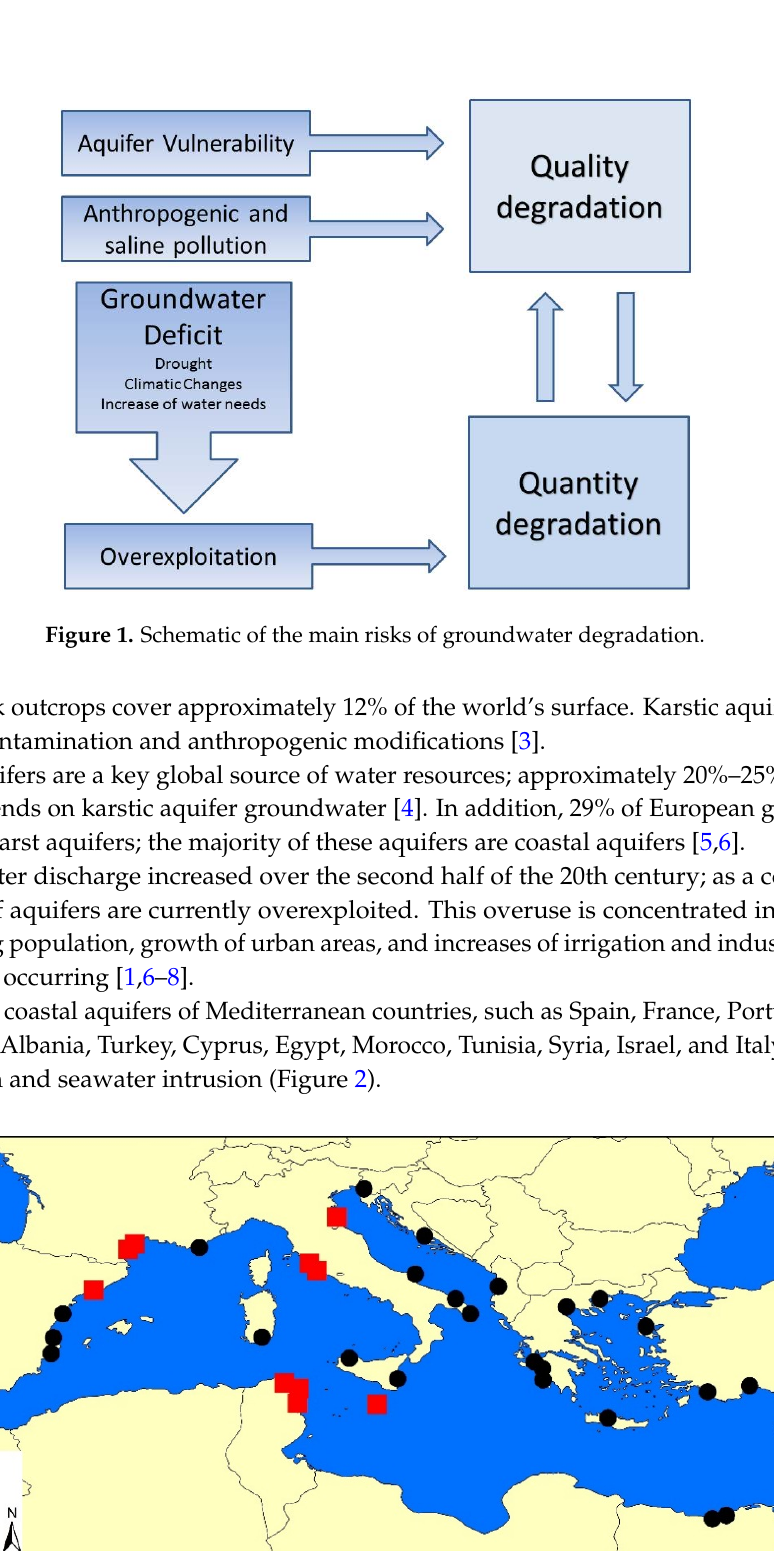
Figure 2. The main Mediterranean coastal aquifers highly affected by groundwater quality